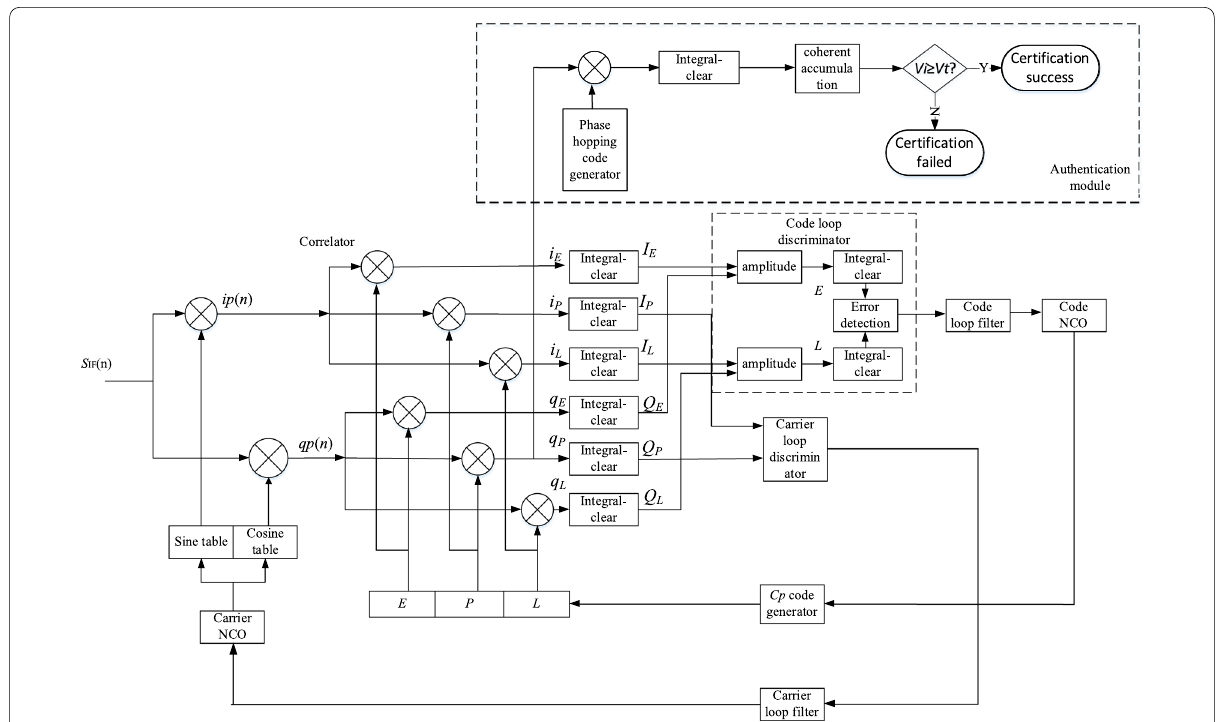
Fig. 4 Schematic diagram of using pilot-channel signal authentication (NCO, Numerically Controlled